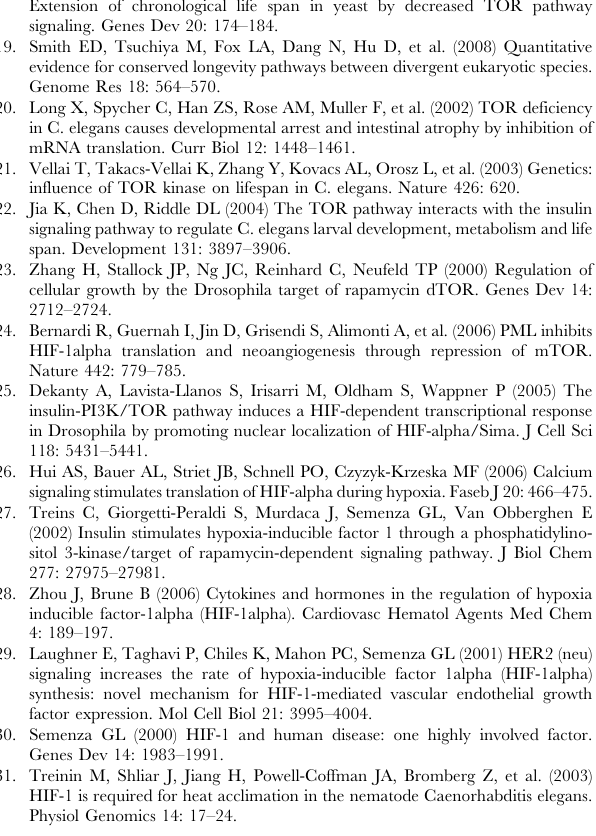
Table S5 IRE-1 is required for lifespan extension by hif-1